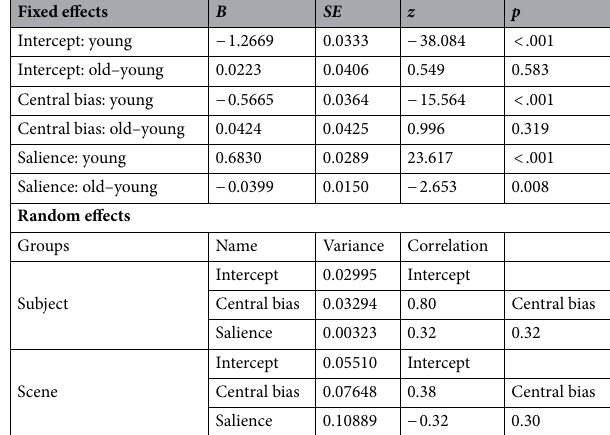
Table 5. Grid GLMM. Age-related effects on fixation probability during scene viewing are modelled with reference to equal-sized, square cells in a grid. Standardized coefficients ( b ), standard errors ( SE ), z - and p -values for fixed effects and variances and correlations for random effects are